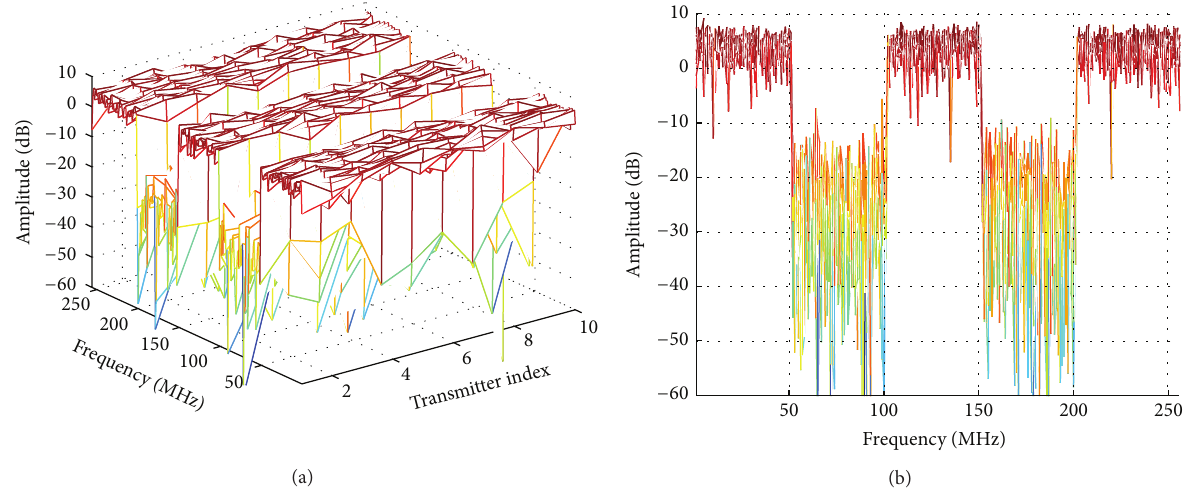
Figure 5: 𝑀 = 10 radar waveforms’ power spectra density: (a) perspective view; (b) front projection.